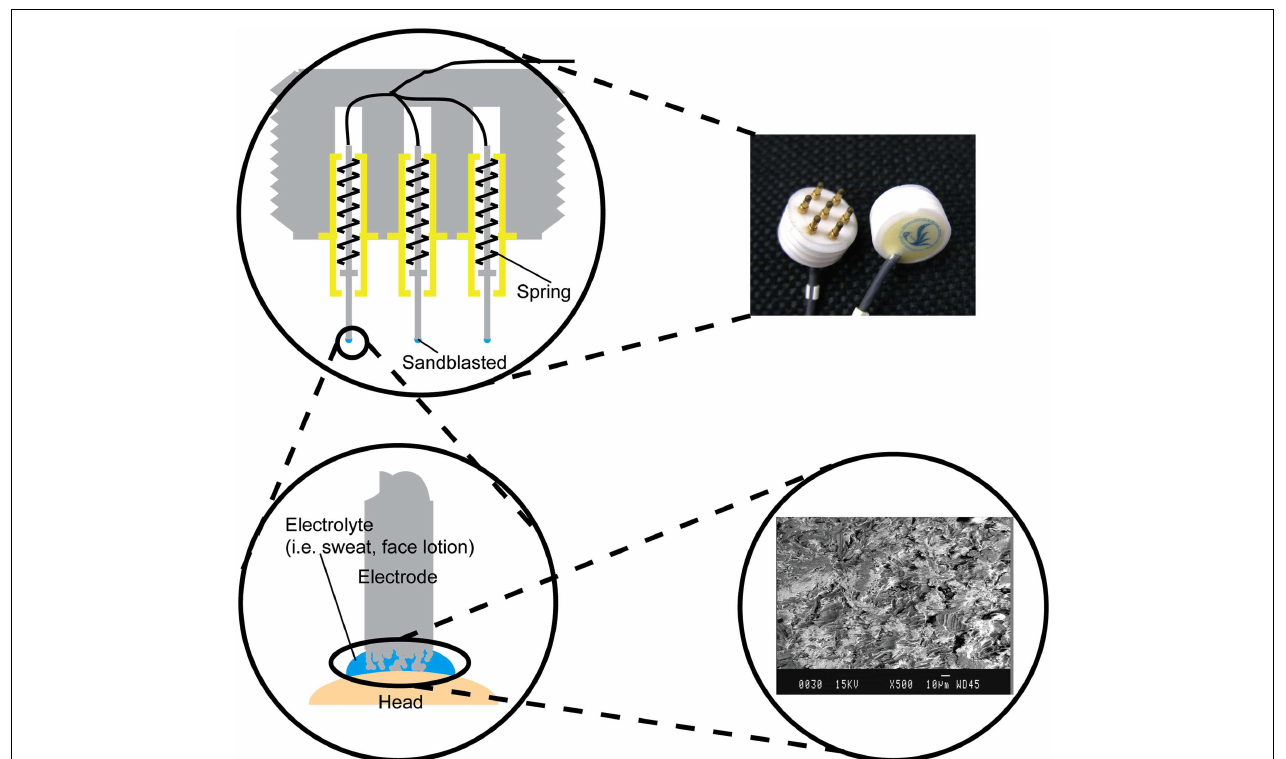
FIGURE 2 | Photograph of the metal-pin electrodes and illustration of the electrode structure. The electrode has seven retractable pins.The tip of each pin was sandblasted to enlarge the effective surface area (see inset scanning electron micrograph).